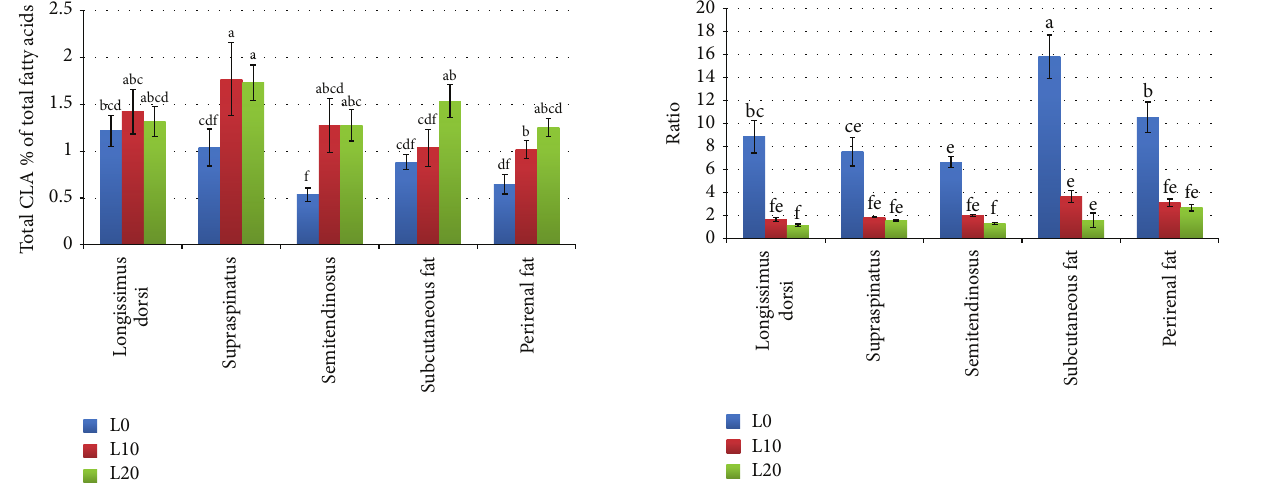
Figure 3: Total CLA contents in muscles and fat tissues of goats fed diets containing different levels of whole linseed. Error bar = (1SE). Bars with different alphabet notation differ significantly.